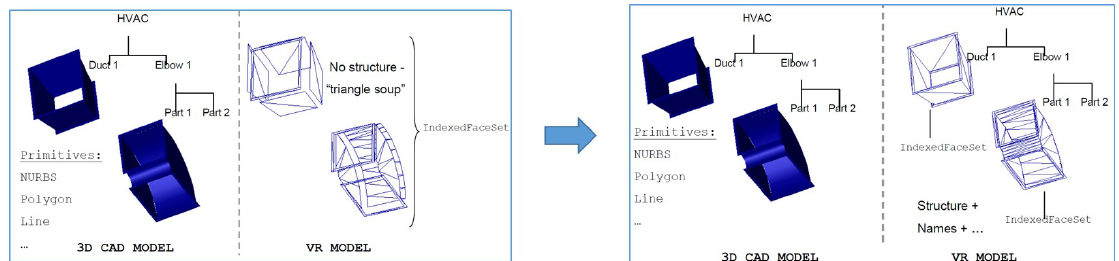
Figure 2. Example of recovering structure and meaning of 3D CAD model while using feature recognition and the STEP standard in the early approach of Posada et al. [6].